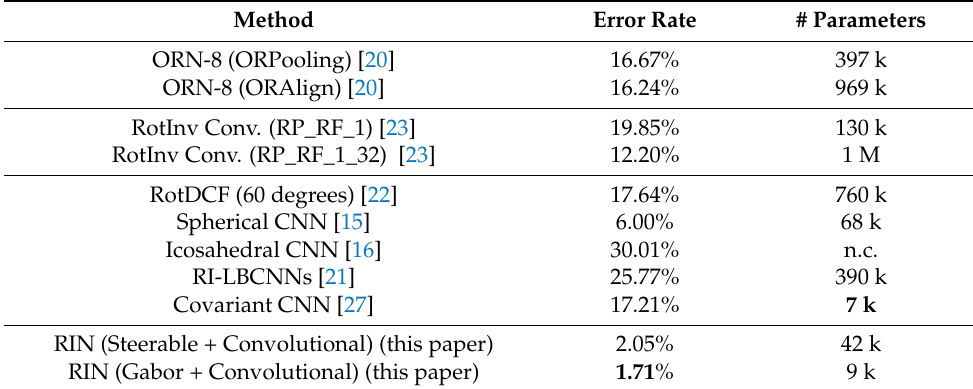
Table 1. Obtained error rate MNIST dataset (training: up-right/validation: